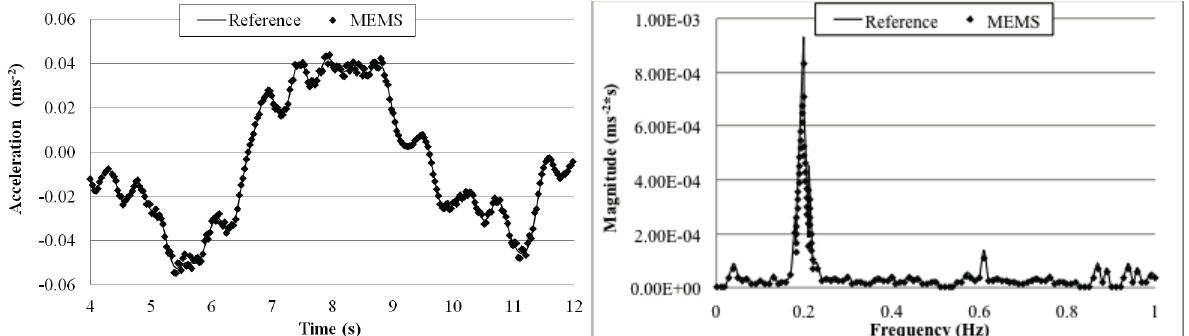
Figure 19. Comparison of measurements by the two sensors in time and frequency domains (0.2 Hz sinusoidal excitation).